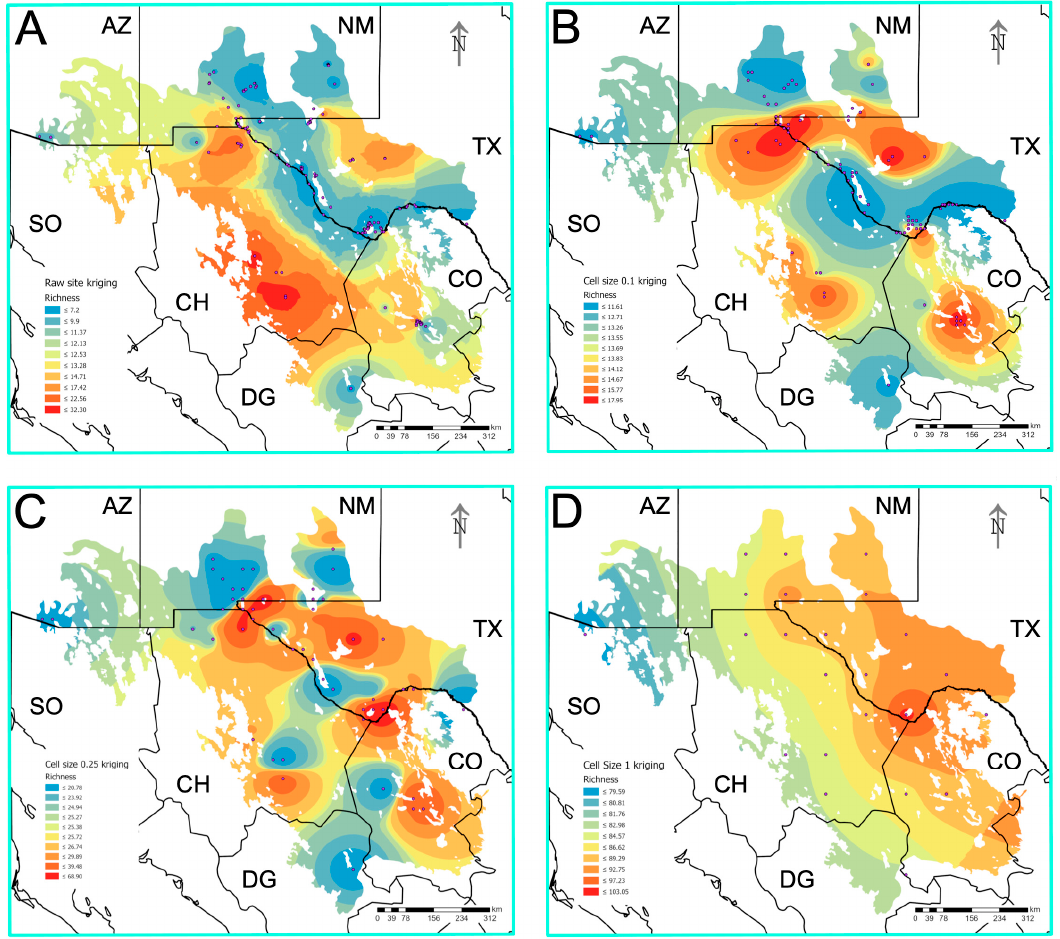
Figure 3. Empirical Bayesian kriging of predicted rotifer species richness within the Chihuahuan Desert ecoregion [123] interpolated from all sites (n = 236) and at a variety of spatial scales. ( A ) All collection sites ( B ) 0.1 ◦ grid cells, ( C ) 0.25 ◦ grid cells, and ( D ) 1 ◦ grid cells. Sites (panel A) and grid cell centroids (panels B–D) are represented by purple dots. We obtained state boundaries from the USGS and ArcGIS online [124]; ArcGIS Mexican state boundary shapefile courtesy of M. Hoel